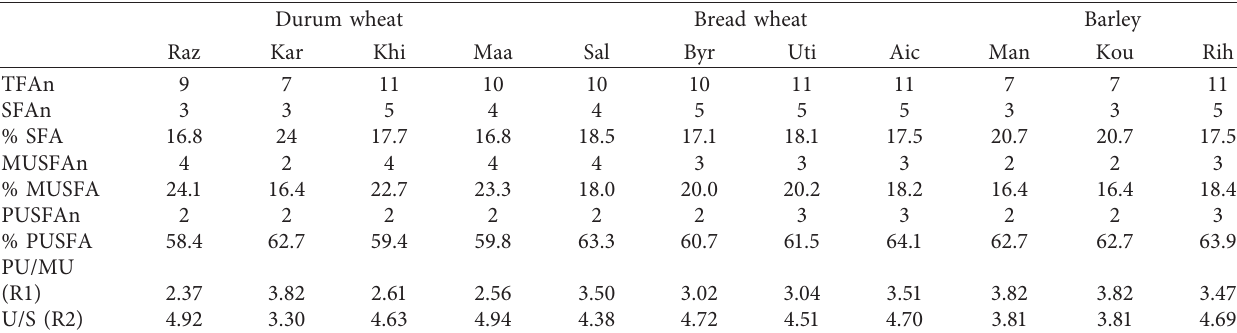
Table 5: Number and amount of the different fatty acids fractions of durum wheat, bread wheat, and barley varieties. Durum wheat Bread wheat